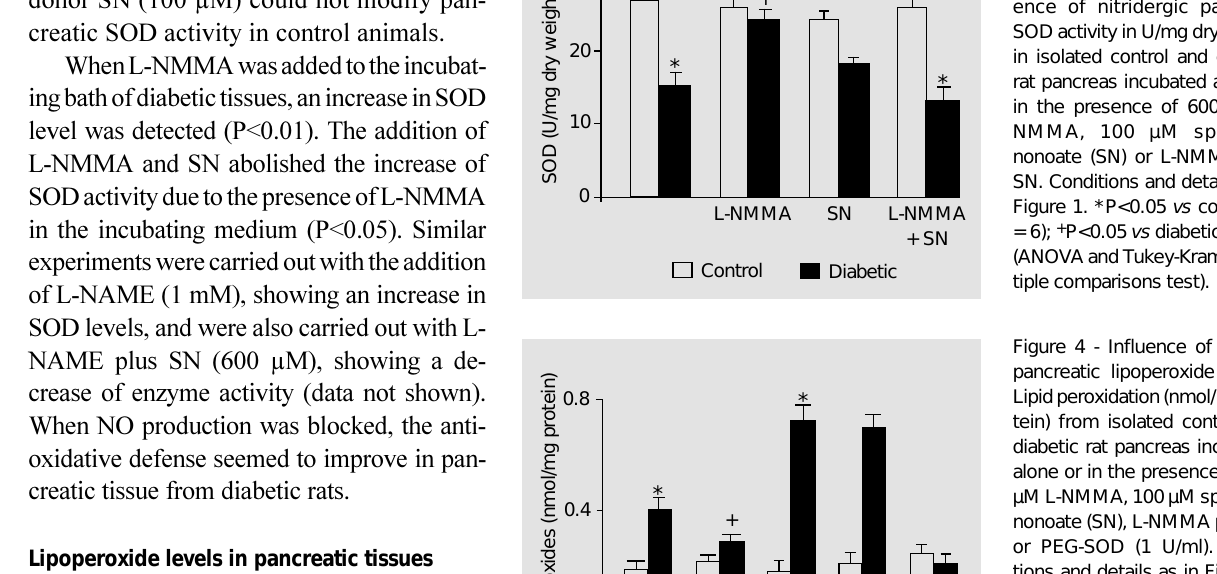
Figure 3 - Pancreatic superoxide dismutase (SOD) activity: influ- ence of nitridergic pathway. SOD activity in U/mg dry weight in isolated control and diabetic rat pancreas incubated alone or in the presence of 600 µM L- NMMA, 100 µM spermine nonoate (SN) or L-NMMA plus SN. Conditions and details as in Figure 1. *P<0.05 vs control (N = 6); + P<0.05 vs diabetic (N = 7) (ANOVA and Tukey-Kramer mul- tiple comparisons test). Figure 4 - Influence of NO on pancreatic lipoperoxide levels. Lipid peroxidation (nmol/mg pro- tein) from isolated control and diabetic rat pancreas incubated alone or in the presence of 600 µM L-NMMA, 100 µM spermine nonoate (SN), L-NMMA plus SN or PEG-SOD (1 U/ml). Condi- tions and details as in Figure 1. *P<0.05 vs control (N = 6); + P<0.05 vs diabetic (N = 8) (ANOVA and Tukey-Kramer mul- tiple